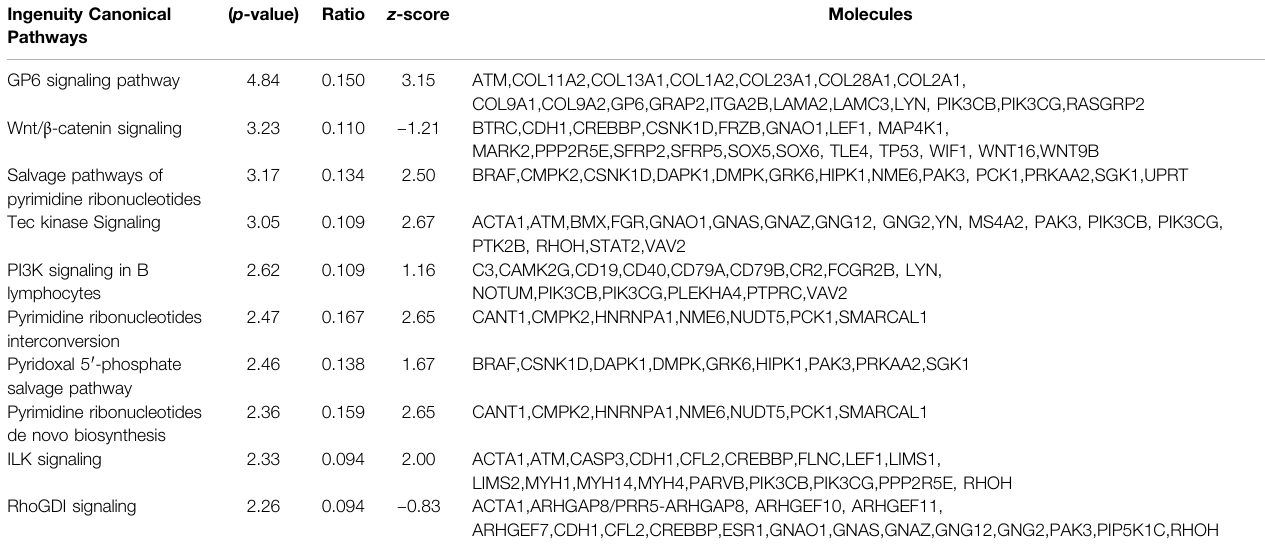
TABLE 4 | The 10 most signi fi cant canonical pathways affected by Dipsacus asperoides ethanolic extract (DAE) treatment. Ingenuity Canonical ( p -value) Ratio z Pathways